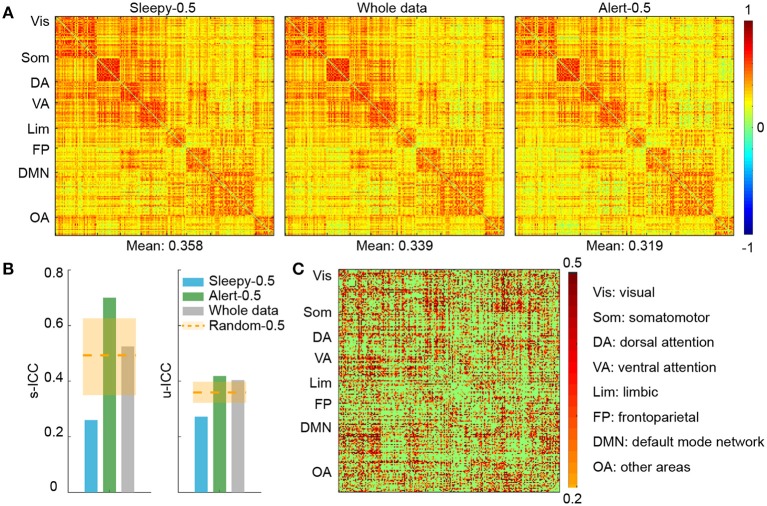
ROI connectivity matrix analysis of alert and sleepy conditions based on RMSSD. (A) Group-level connectivity matrices derived from the sleepy-0.5, whole-scan and alert-0.5 conditions during session A. ROIs were organized according to the 7-network system (Yeo et al.), as labeled on the left of each panel. The mean connectivity strength of each condition is indicated on the bottom of each matrix. The connectivity matrices in session B are very similar to those in session A, and thus not presented. (B) Functional connectivity ICCs during resting state at both scan- (left panel) and unit-wise (right panel) levels. Unit-wise ICC was averaged across ROI pairs. Orange dashed lines indicate the average ICC values of the random-0.5 conditions, and the shaded boxes indicate their distributions—upper and lower bounds marking the 95 and 5 percentiles, respectively. Values outside the boxes are significantly different from the random conditions (one-tailed permutation test, p < 0.05). (C) Unit-wise ICC differences between alert-0.5 and sleepy-0.5 conditions (warm color: alert-0.5 > sleepy-0.5; cool color: alert-0.5 < sleepy-0.5). Differences greater than 0.2 are displayed.